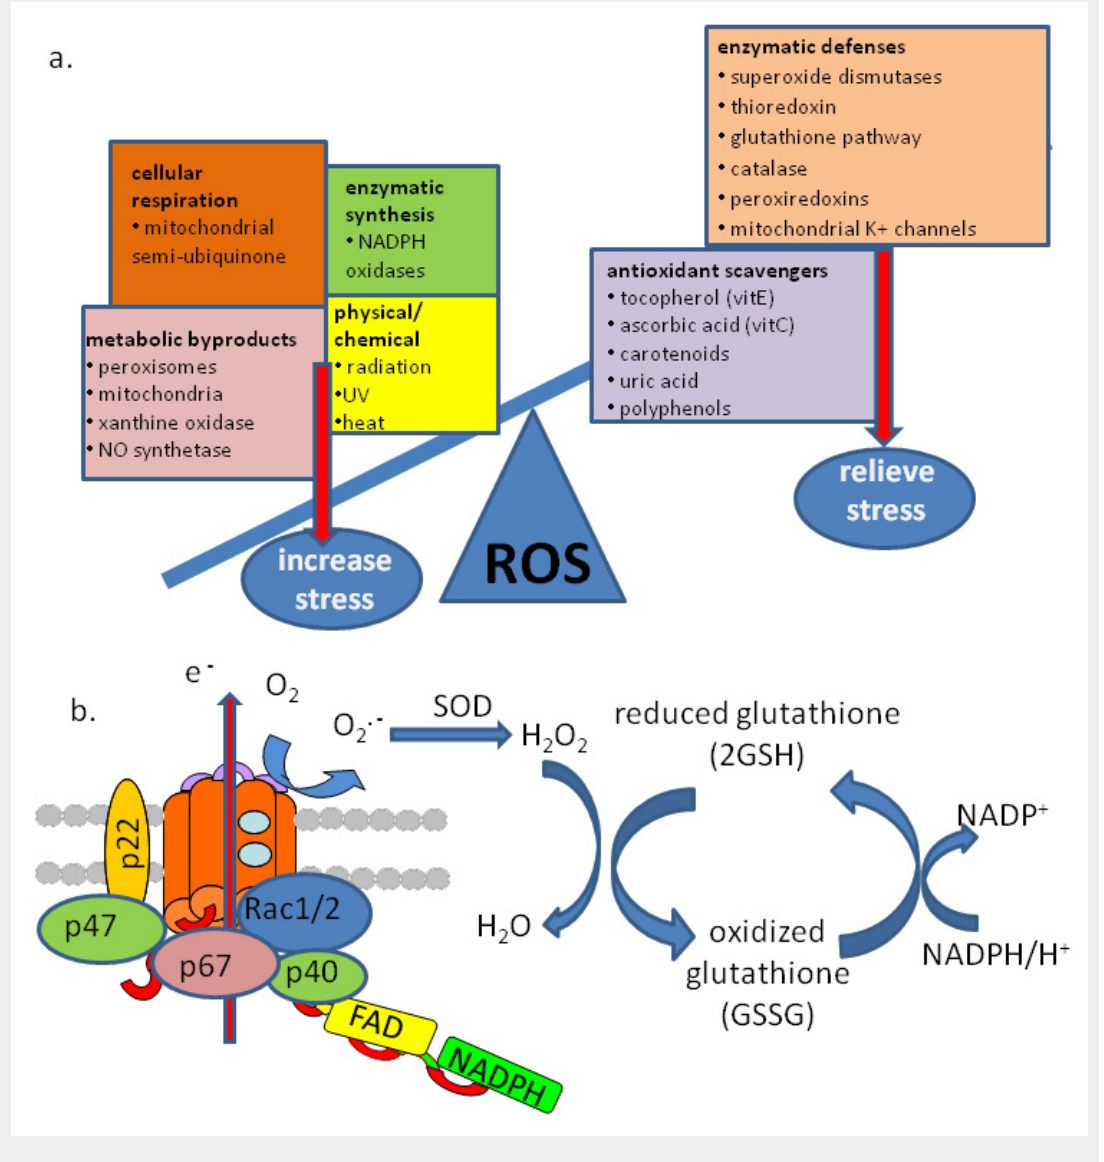
Figure 3 (a) ROS generation and degradation contributing to the oxidative balance. (b) The NOX2/p22phox complex, consisting of NOX2 (orange) and the subunits p47, p67, and p40 (left) and glutathione defense mechanism (right). The superoxide (O 2.– ) generated by the NOX complex is rapidly dismutated by superoxide dismutatase (SOD), where it can enter the glutathione synthesis and recuperation